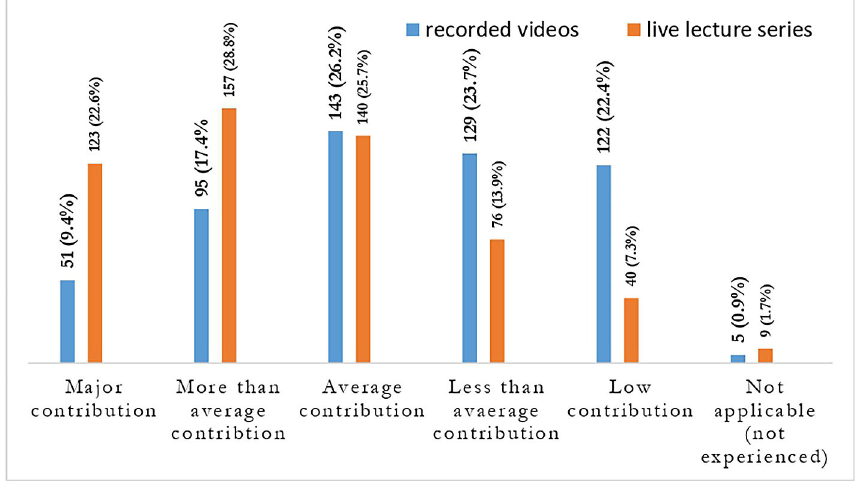
Figure 5. Students response showing the contribution of live lectures in comparison to recorded lectures.